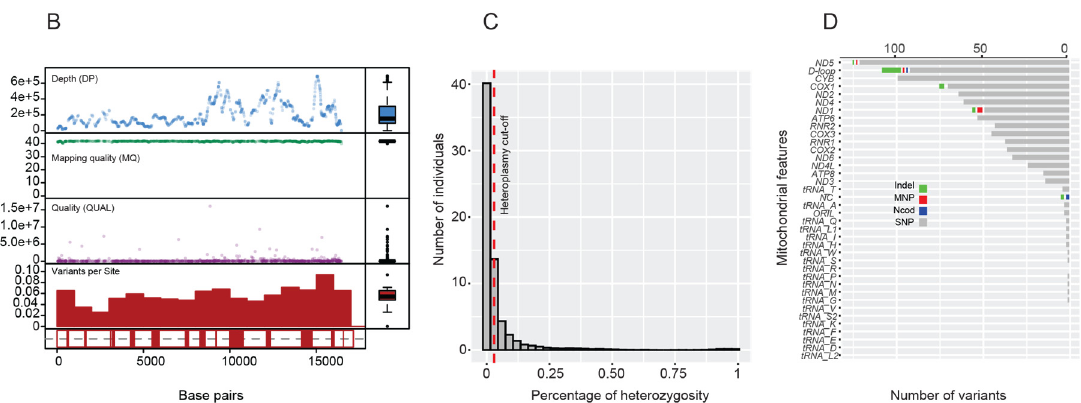
Figure 1. Mitochondrial genomic variation within the UAE population. ( A ) Circos plot depicting the overall mitochondrial genomic variation. From the outer to inner rings: (1) variant allele frequency, (2) variant type, and (3) gene positions. The inner barplot shows the synonymous and nonsynonymous variants for each mitochondrial gene. ( B ) Quality control statistics such as depth of coverage (DP), mapping quality (MQ), and quality of variants (QUAL), as well as the number of variants per site. ( C ) Percentage of heterozygosity as a proxy for heteroplasmy for heterozygote variants depicted on the x -axis. The y -axis is the number of individuals with heteroplasmic locus. ( D ) The number of variants distribution per mitochondrial gene, RNR, tRNA, and noncoding.